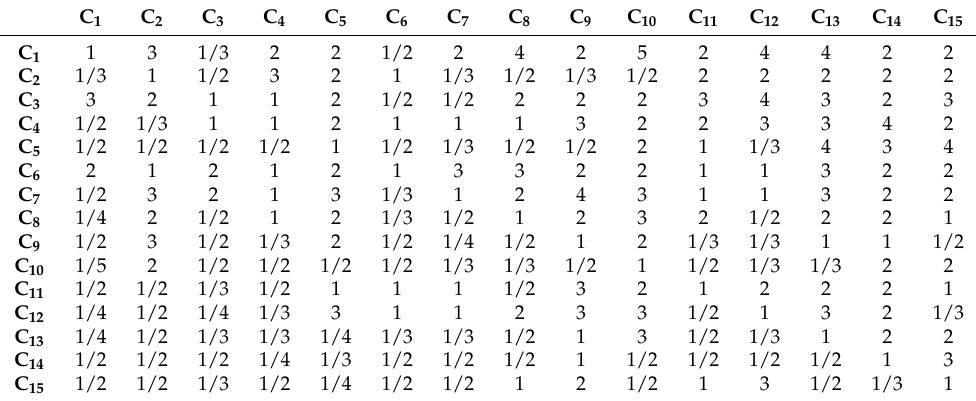
Table 12. Pairwise comparison